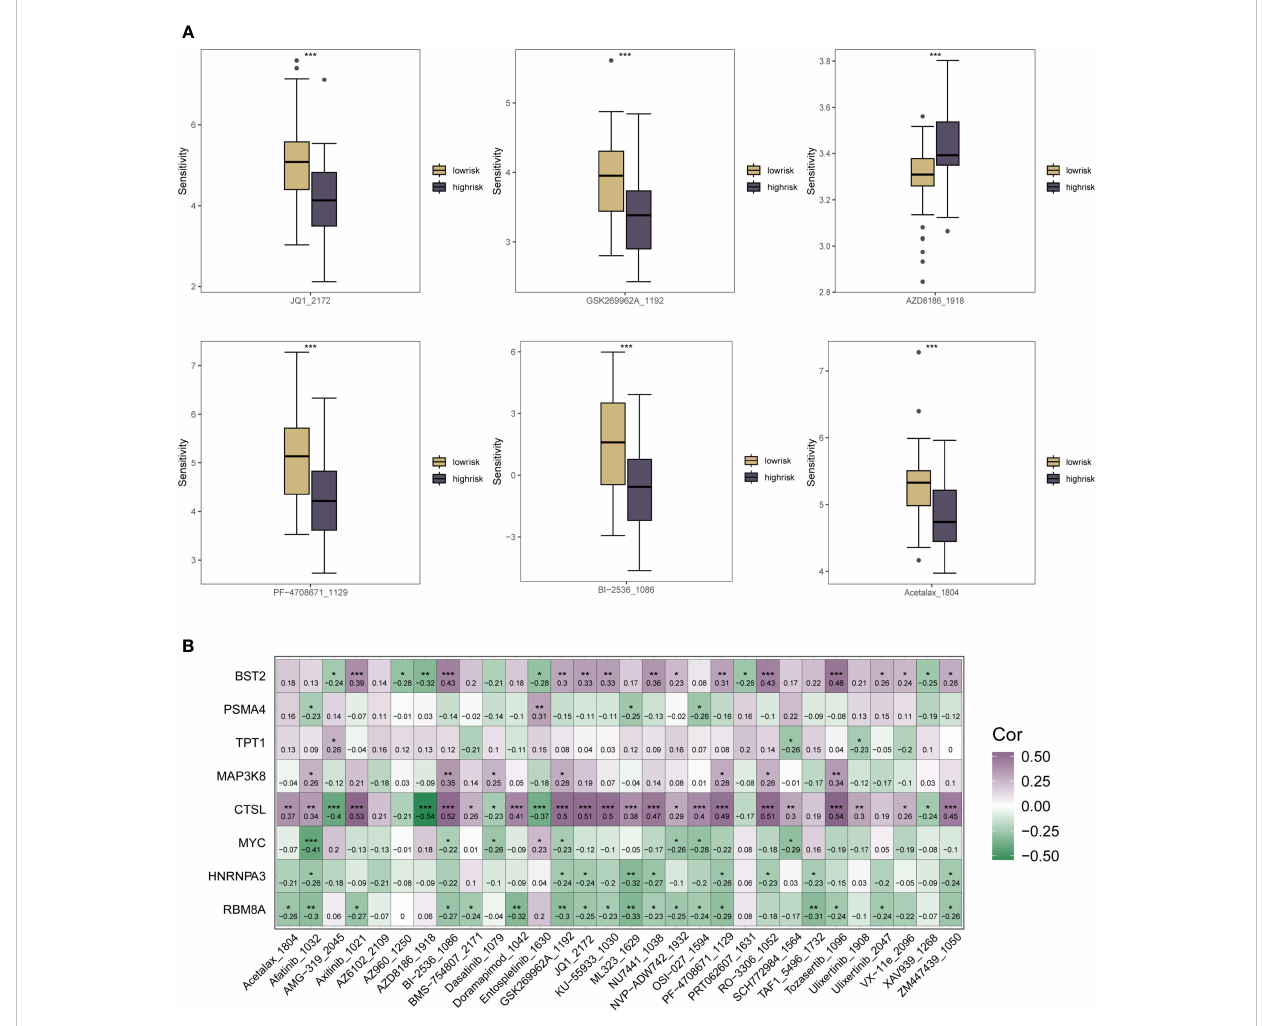
FIGURE 6 Correlation analysis of the riskscore expression of m6A in ESCC patients with the sensitivity scores of drugs in the GDSC database. (A) Box plots of speci fi c expression associations between treatment sensitivity and riskscore groupings for multiple oncology therapies. Chemotherapeutic agents include AZD8186_1918, SK269962A_1192, Acetalax_1804, Bl-2536_1086, JQ1_2172, PF-4708671_1129; (B) Correlation heat map analysis further clari fi es the therapeutic sensitivity of multiple chemotherapeutic agents with speci fi c each gene in the m6A risk model for expression correlation. * means <0.05, ** means <0.01, *** means